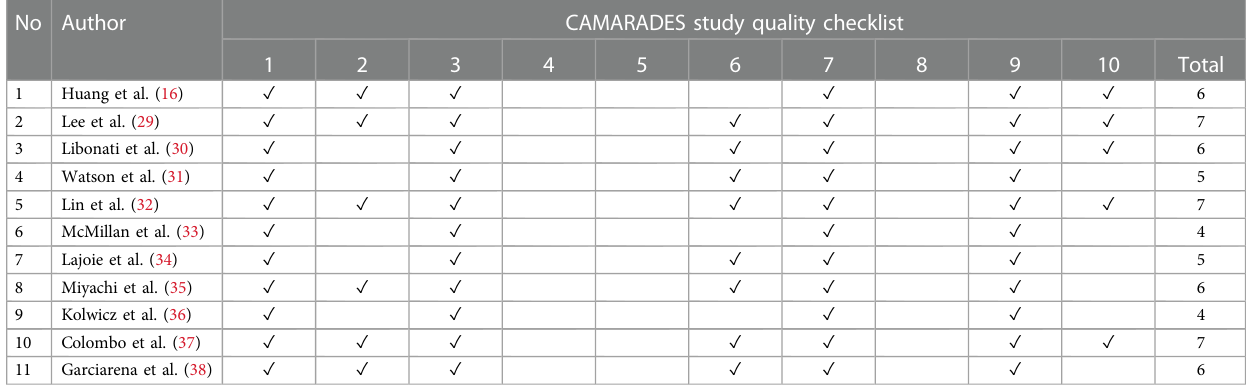
TABLE 2 CAMARADES study quality